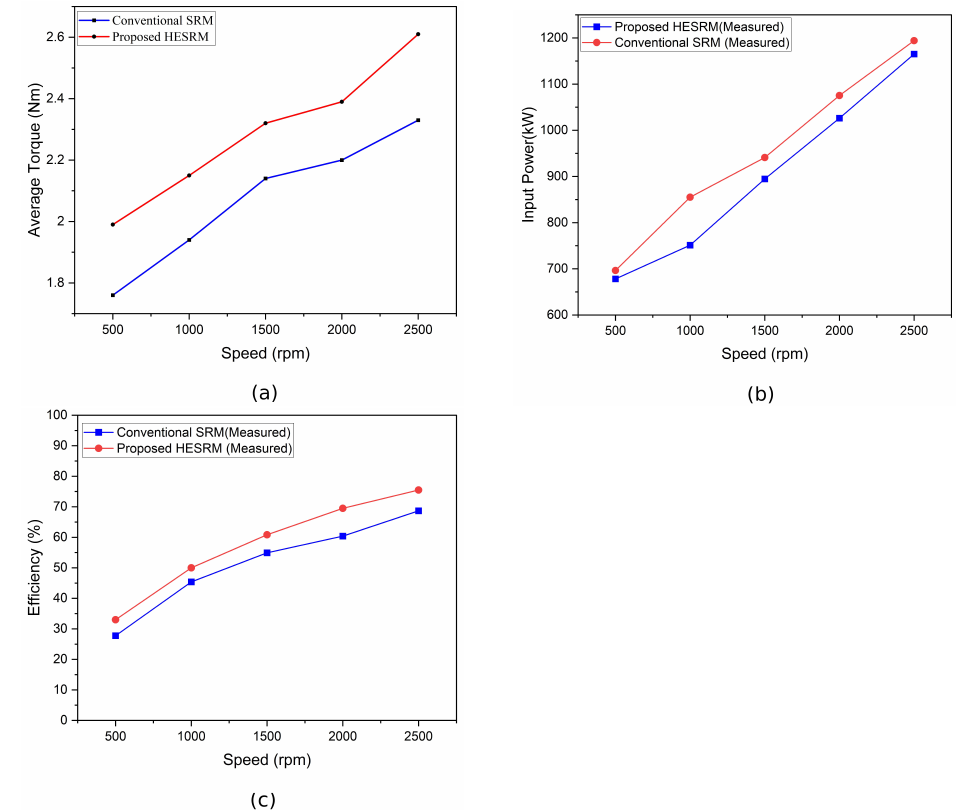
Figure 18. Comparison of conventional SRM with proposed HESRM: ( a ) average torque, ( b ) efficiency, and ( c ) input